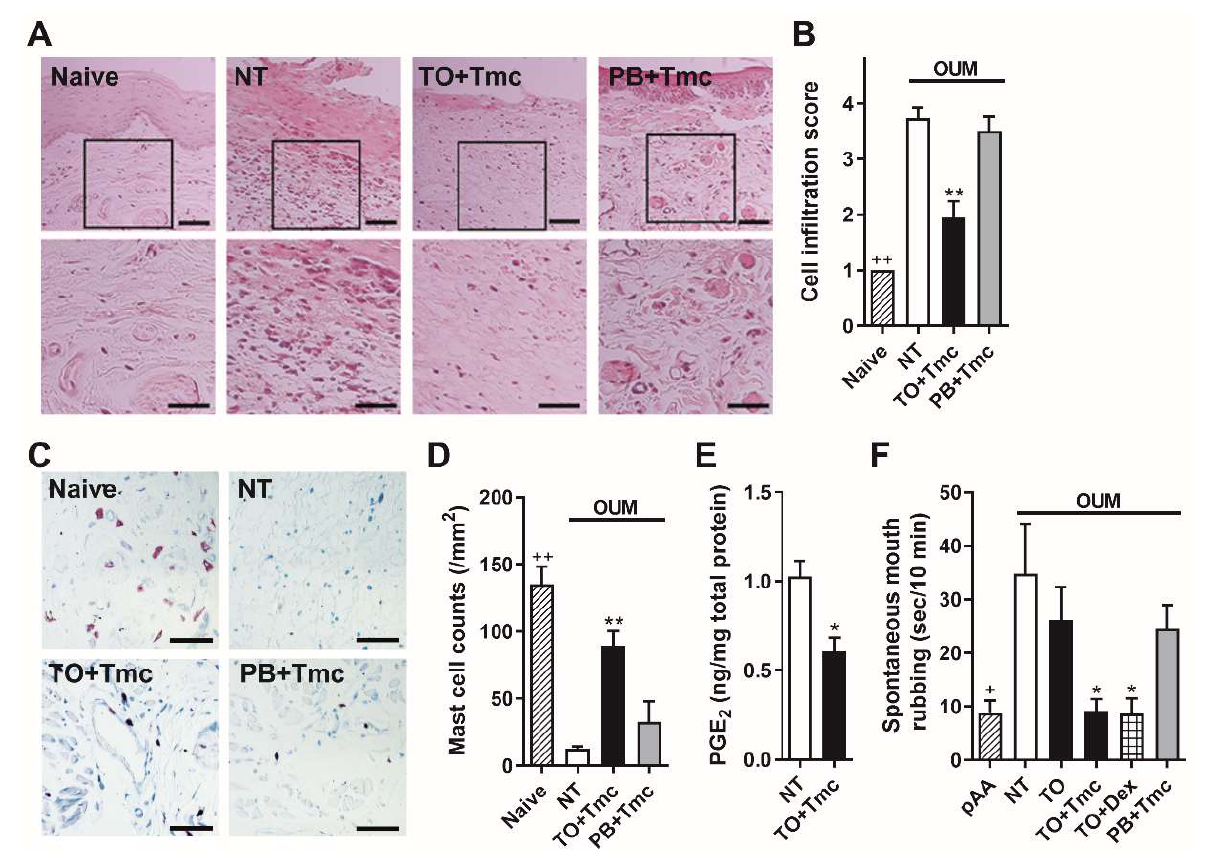
Figure 2. Anti-inflammatory effects of triamcinolone acetonide (Tmc) in Traful ointment (TO) and analgesic effect on spontaneous pain in the oral ulcerative mucositis model (OUM, 2 days after the acetic acid procedure). ( A ) Representative histological images of the oral mucosa in the naive rats and the oral ulcerative mucositis after local treatments with Tmc- containing ointments. NT: non-treatment, TO + Tmc: TO with Tmc and PB + Tmc: Plastibase with Tmc. Microphotographs in the lower panel are enlarged from square area in the microphotographs in the upper panel (scale bars = 50 µm). Oral ulcerative mucositis sections were collected from the OUM following 2 coats of ointments. Tissue sections from the other 2 rats in each group exhibited the same features. ( B ) Semi-quantitative analyses of inflammatory cell infiltration in the oral mucosa ( n = 3 in each group) using a 4-step score (1: none, 2: mild, 3: moderate and 4: severe). ++ p < 0.01 between naive and NT according to Student’s t -test ( d = 8.00). Among OUM rats, ** p < 0.01, compared with NT according to Sidak’s test following one-way ANOVA ( f = 0.79) ( C ) Representative toluidine blue-stained images of the oral mucosa in the naive and the OUM rats after local treatments with Tmc-containing ointments. ( D ) Quantitative analyses of mast cell counts in the oral mucosa ( n = 3 in each group). ++ p < 0.01 between naive and NT according to Student’s t -test ( d = 7.49). Among OUM rats, ** p < 0.01, compared with NT according to Sidak’s test following one-way ANOVA ( f = 0.85) ( E ) Prostaglandin E 2 (PGE 2 ) levels in the oral ulcerative mucositis in the NT and TO + Tmc rats (each n = 4). * p < 0.05, compared with NT according to Student’s t -test ( d = 2.55). ( F ) Effects of ointments on spontaneous mouth rubbing. NT (pAA: before the acetic acid procedure in the same rats), TO: TO alone, TO + Tmc, TO + Dex: TO with dexamethasone and PB + Tmc; each group n = 5. + p < 0.05 between pAA and NT according to Student’s t -test ( d = 1.45). Among OUM rats, * p < 0.05, compared with NT according to Sidak’s test following one-way ANOVA ( f = 0.20).